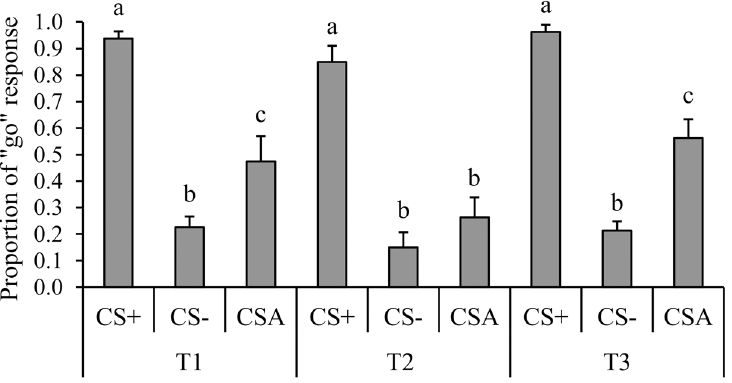
Fig 2. The average (+ SE) proportion of ‘ go ’ responses of white-lipped peccaries in each test (T1, T2 and T3) by each cue type (CS+, CS-, CS A ). Different letters (a 6¼ b 6¼ c) represent significant differences and same letters indicate non-significant